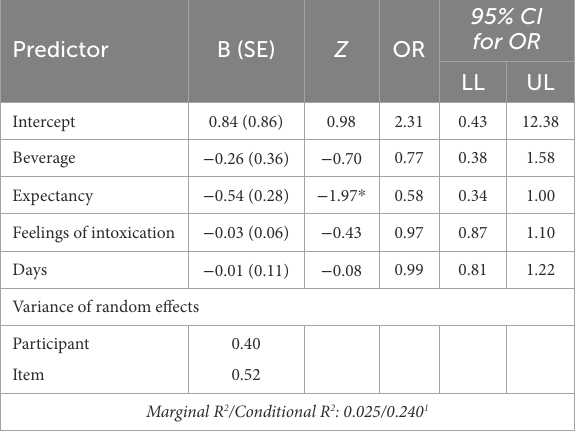
TABLE 1 Multi-level logistic regression analyses predicting memory accuracy for non-consensual sexual activity.